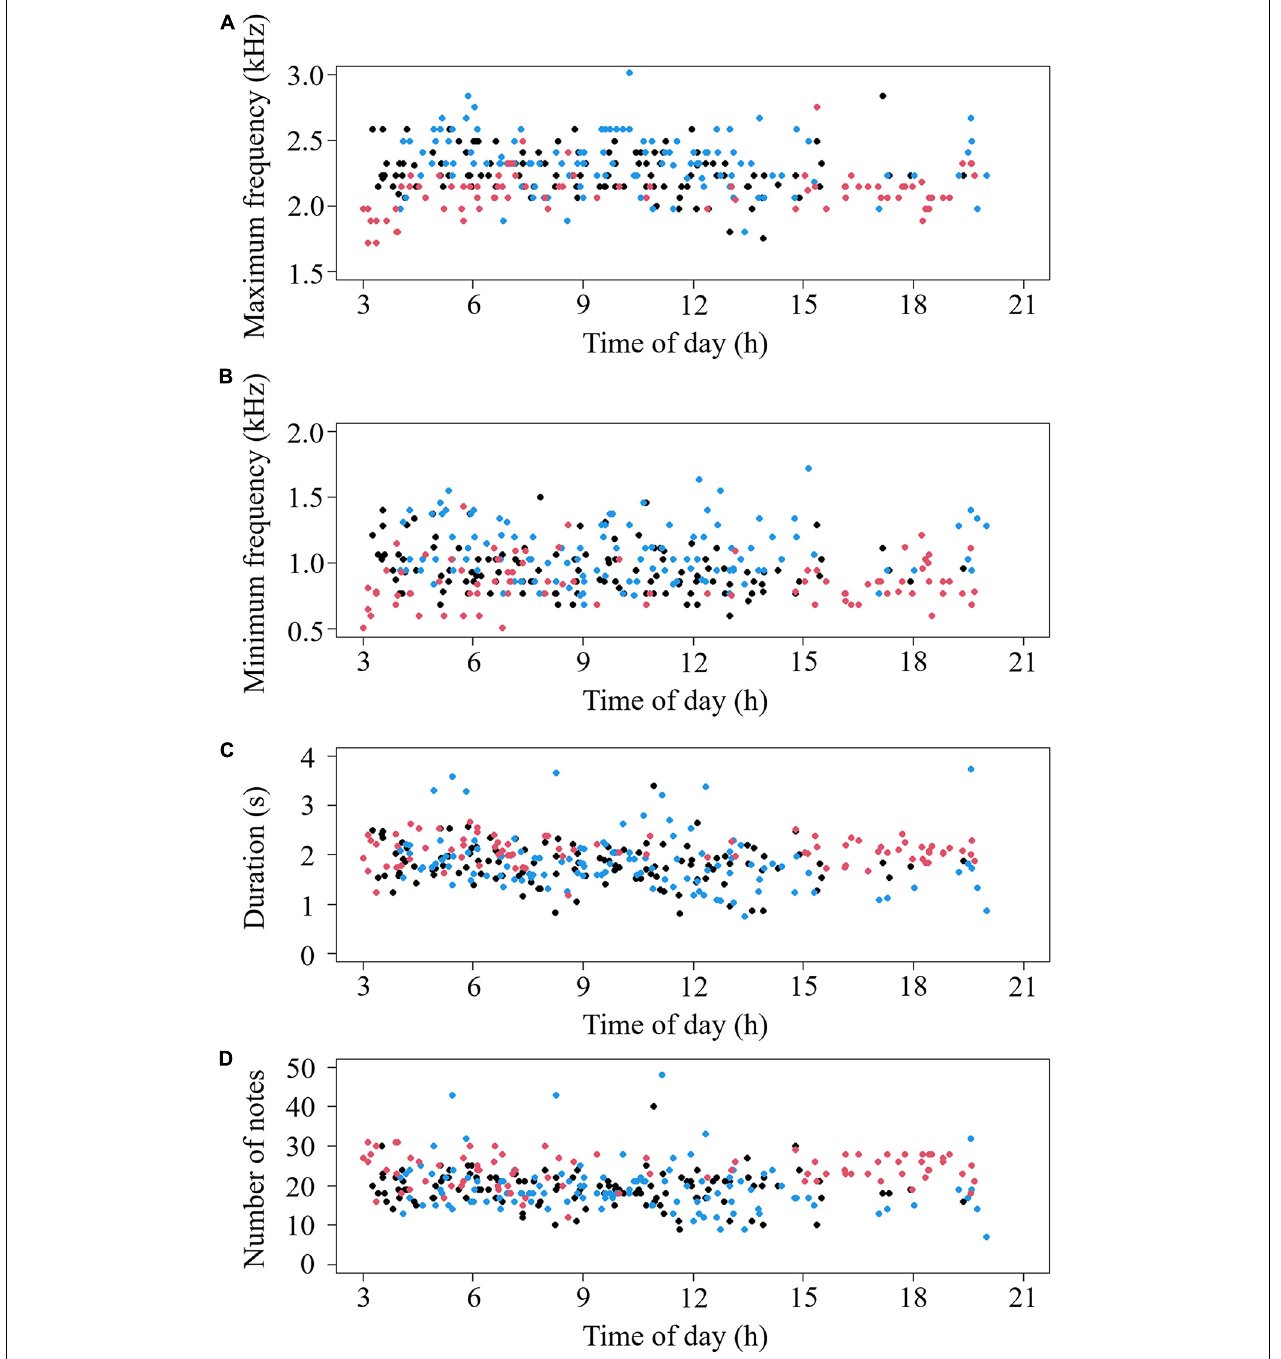
FIGURE 4 | Characteristics of female common cuckoos “bubbling” calls plotted against time of day: maximum frequency (A) , minimum frequency (B) , duration (C) , and number of notes (D) . The black points indicate calls from Liaohe Delta Nature Reserve; the blue points indicate calls from Wild Duck Lake; and the red points indicate the calls from Dagangzi National